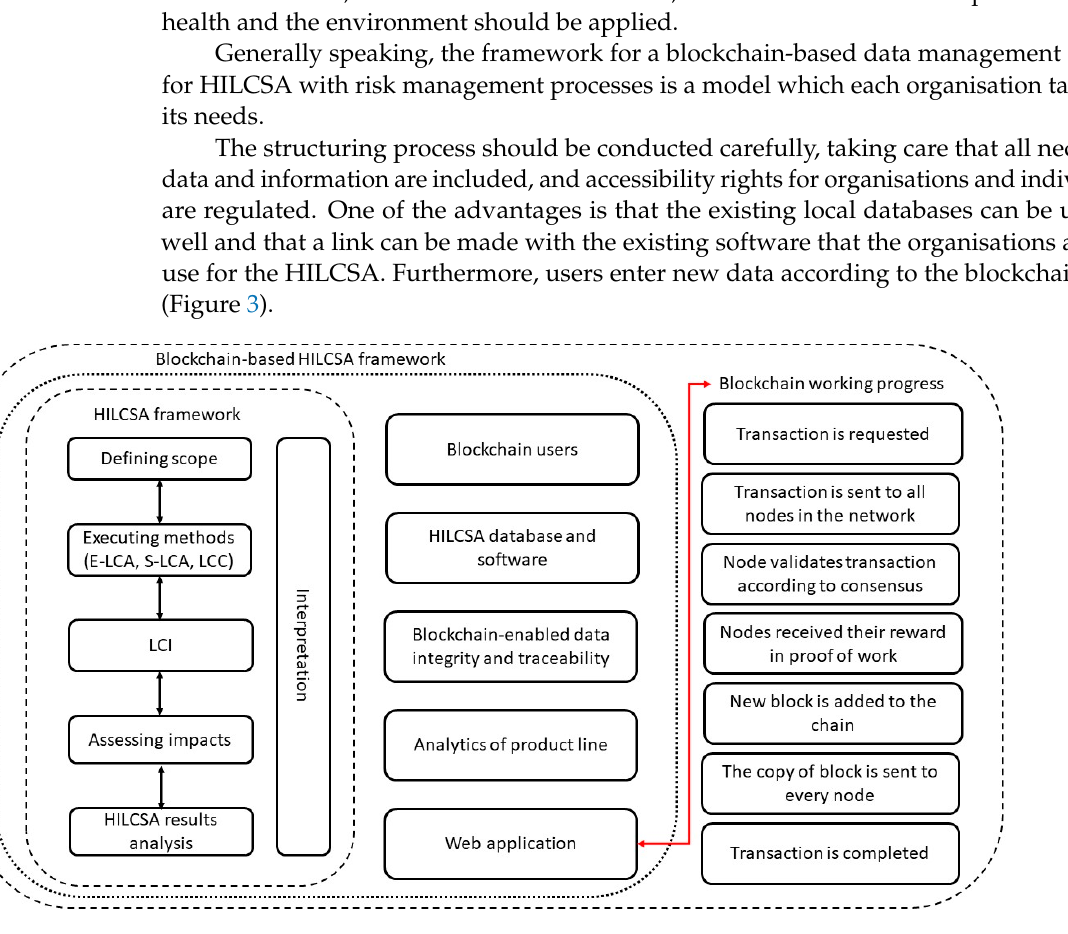
Figure 3. Blockchain-based HILCSA framework and blockchain working progress. Source: Authors.